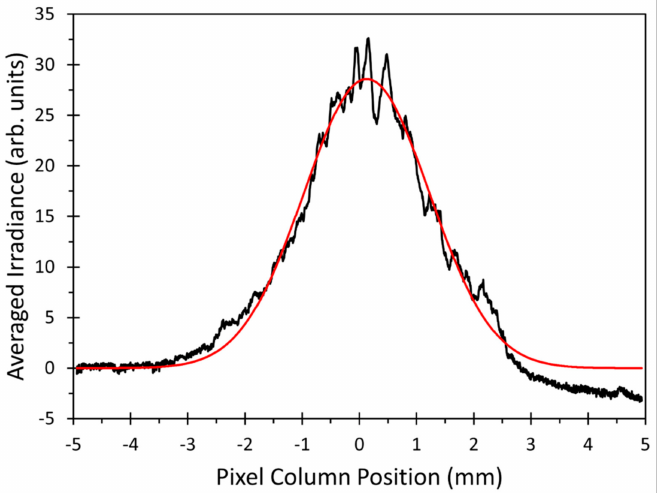
Figure 11. Column averaged beam profile of the laser beam in Figure 10a (black line) together with the corresponding Gaussian fit function (red